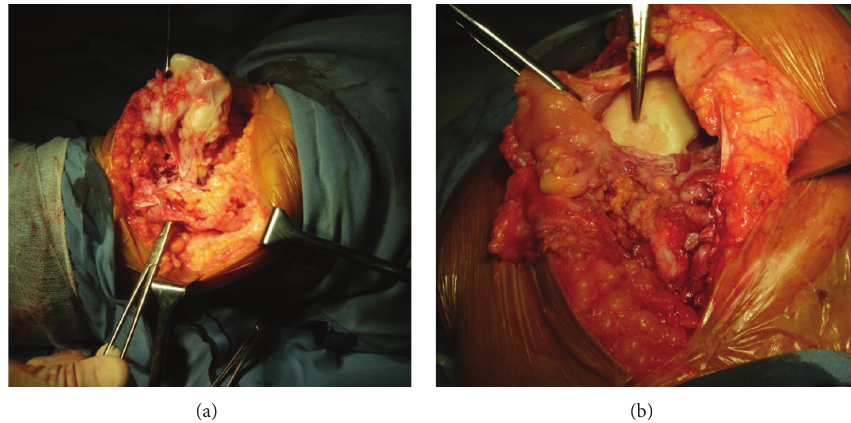
Figure 4: Intraoperative findings. (a) Tumour medial to the patellar tendon and (b) tumour impaling medial femoral condyle.